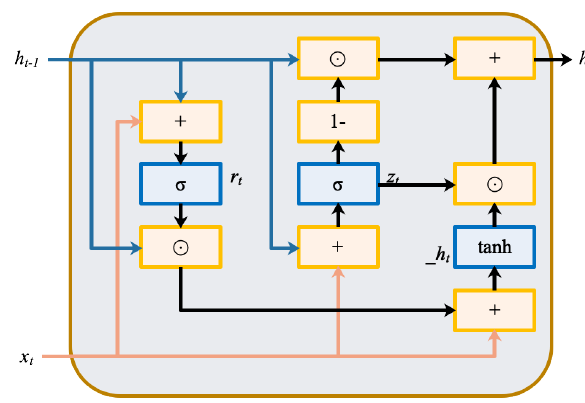
Figure 3. Schematic of the generator load